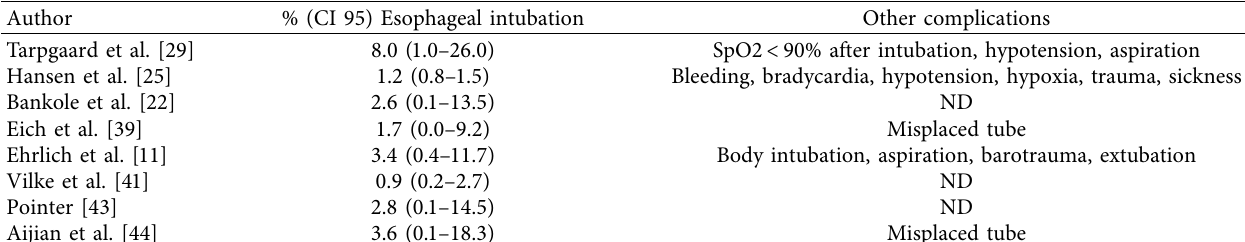
Table 2: Frequency of esophageal intubation and other procedure-related complications.